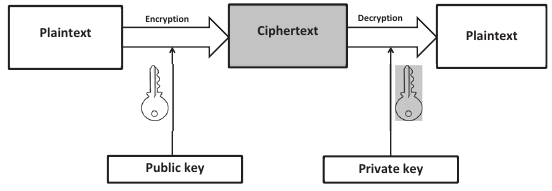
Table 1: Number of rounds depend on the key length.